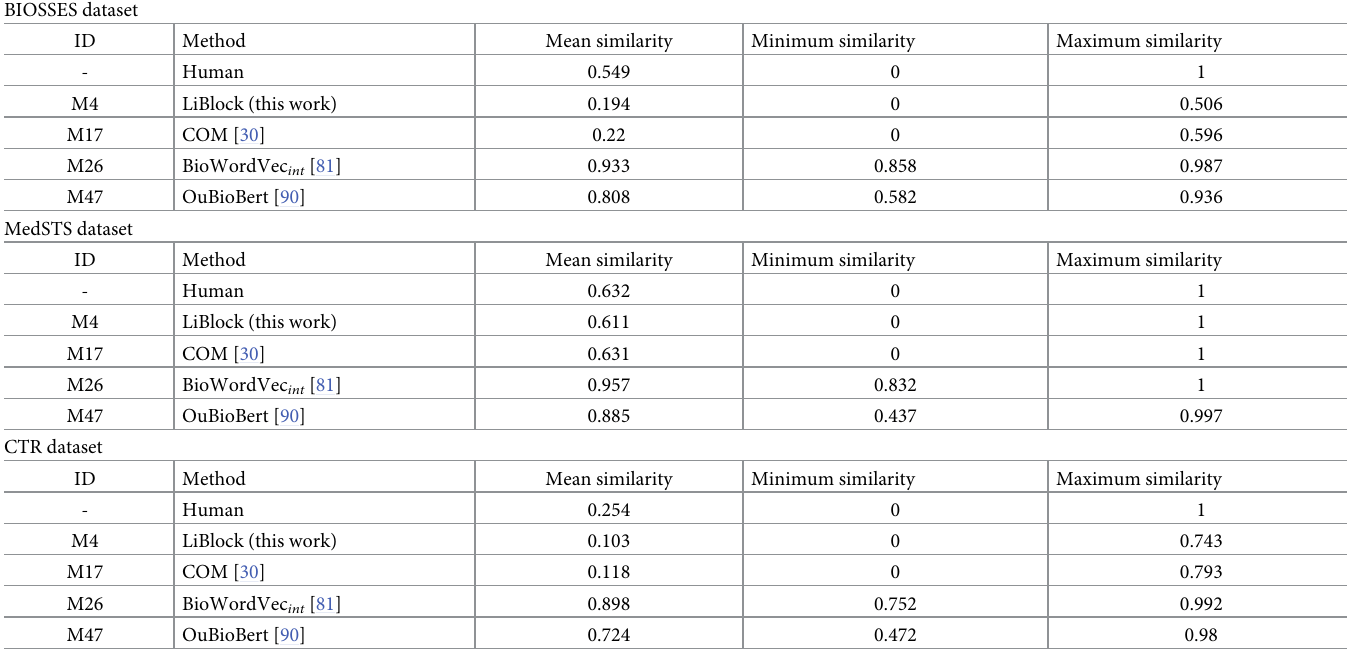
Table 17. Comparison of the mean, minimum and maximum similarity scores of the Normalized Human similarity scores (Human) and the estimated values returned by the best-performing methods of each family in the evaluation of the three biomedical datasets. BIOSSES